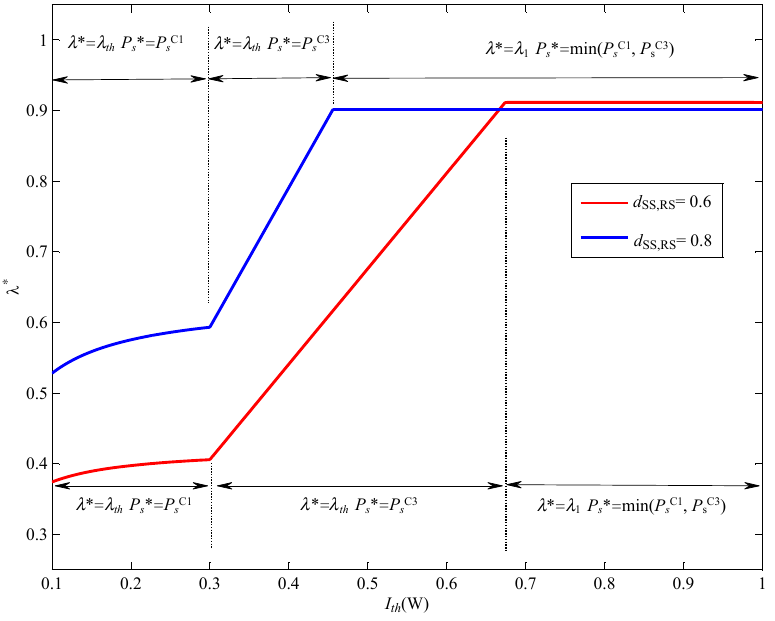
Figure 11. The optimal value of λ versus I th